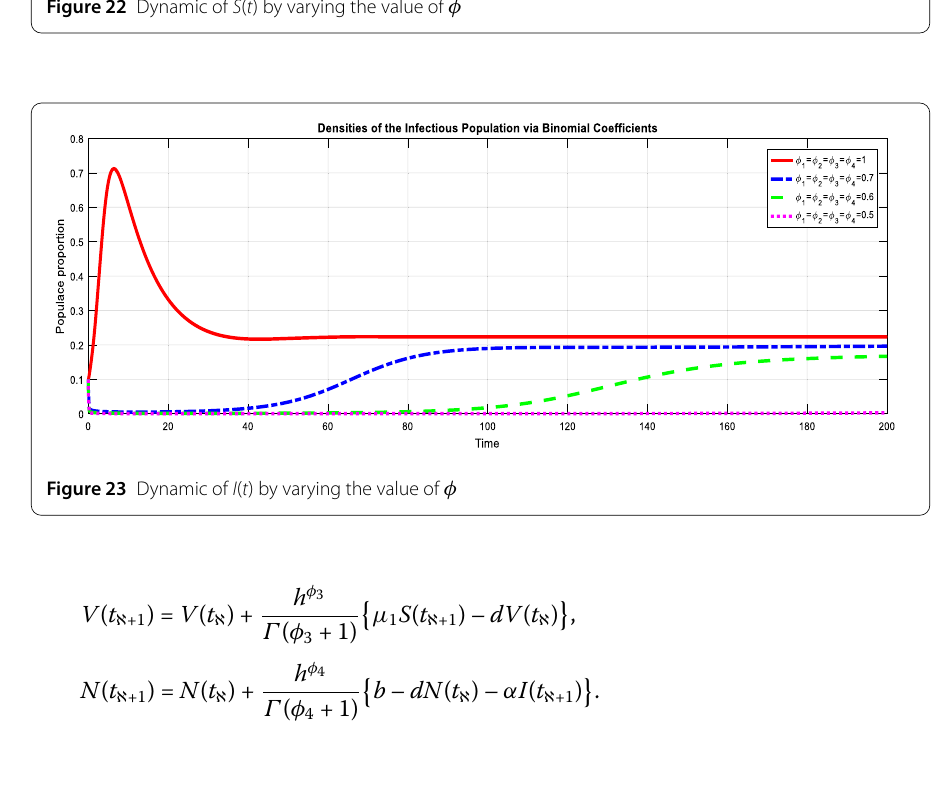
Figure 22 Dynamic of S ( t ) by varying the value of φ